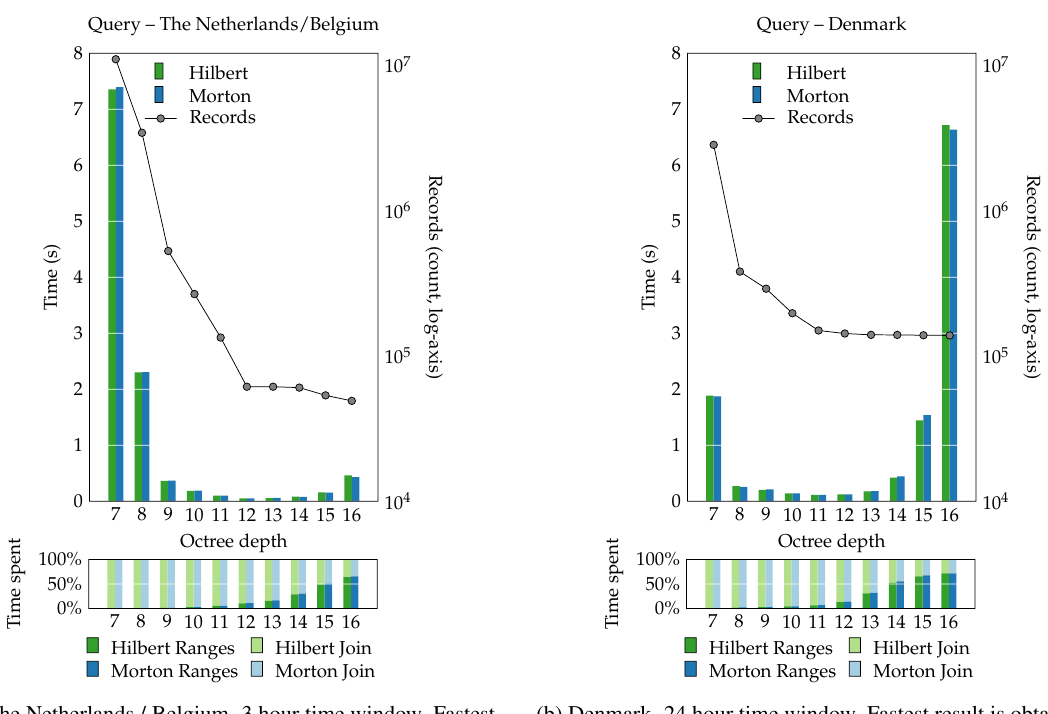
(b) Denmark. 24 hour time window. Fastest result is obtained at depth 11 (generating 149,188 records), taking 115 milliseconds.